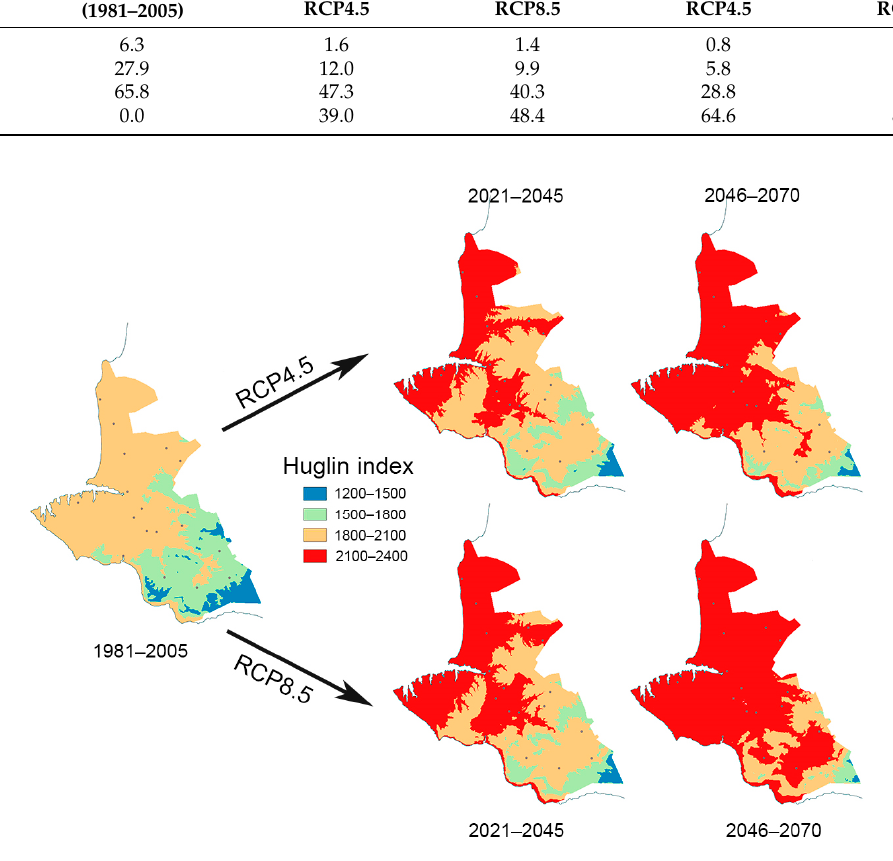
Figure 5. Spatial distribution of the Huglin index over the Sevastopol region obtained by the ensemble of RCMs for the base (1981–2005) and two future periods (2021–2045 and